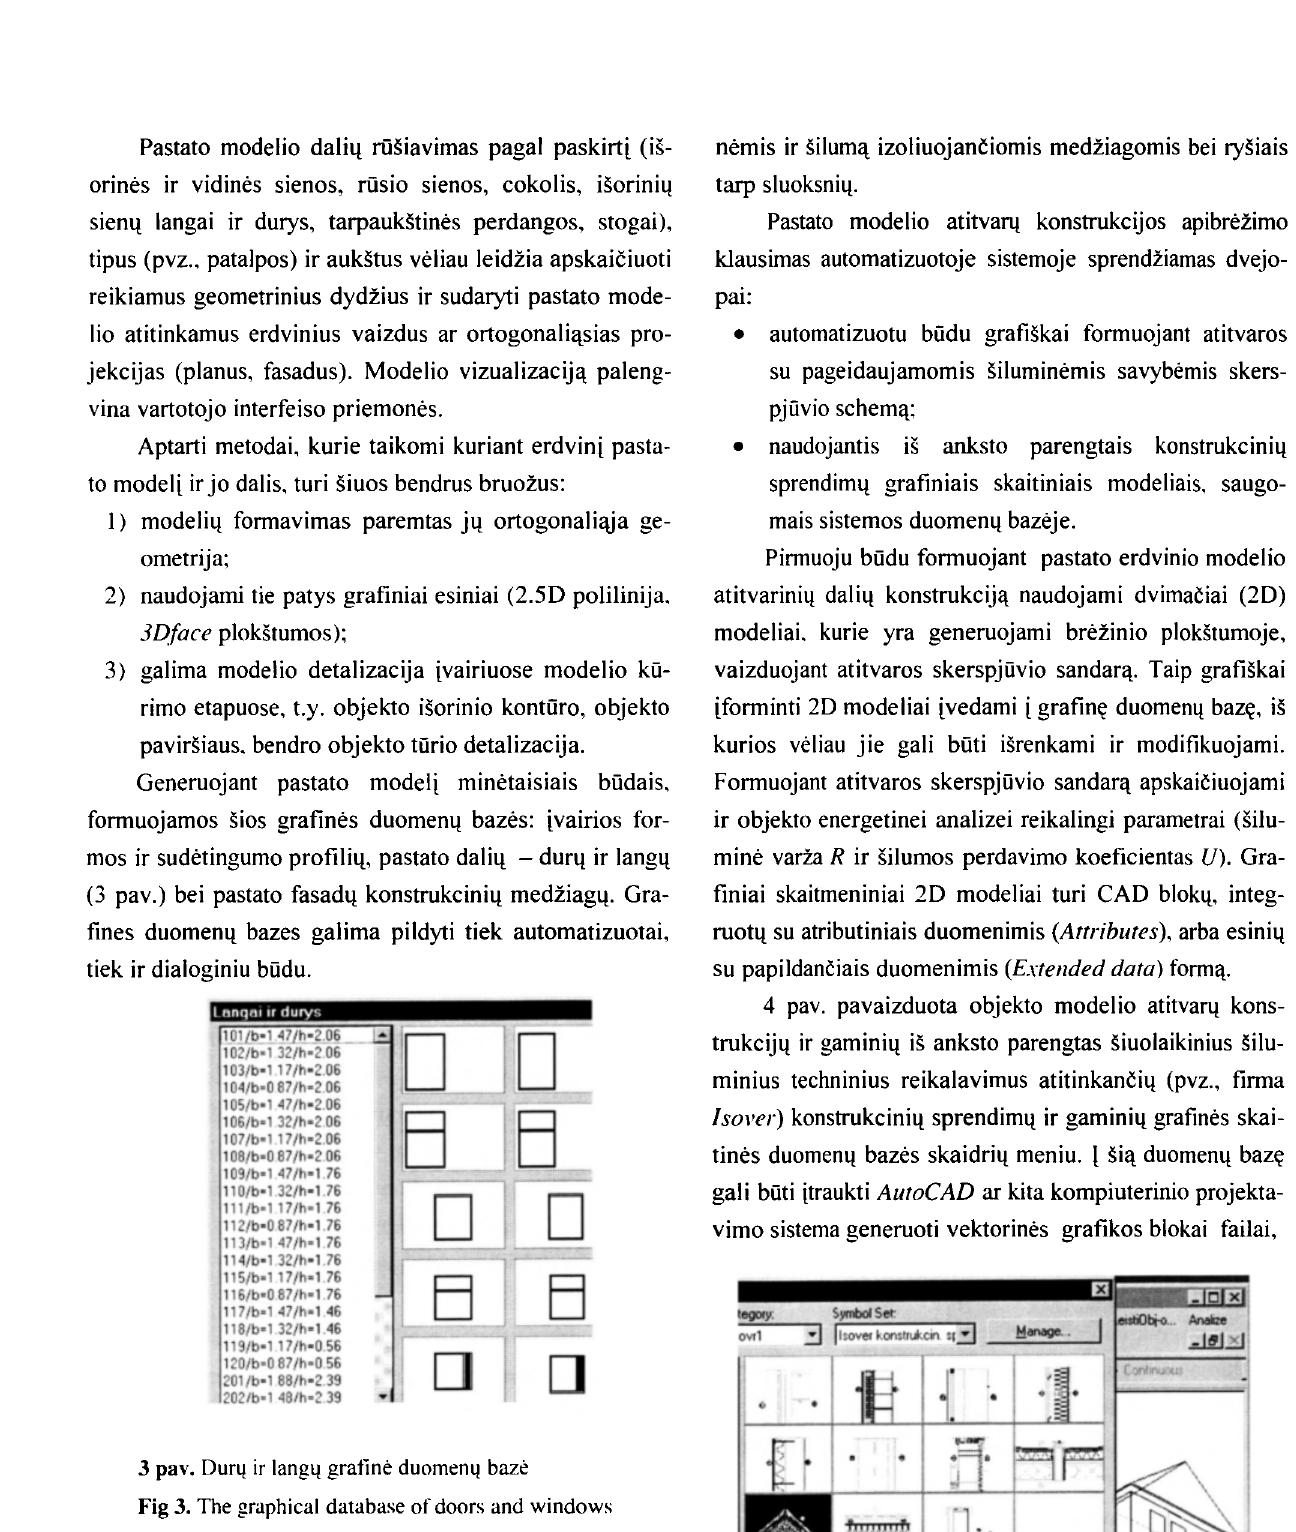
Fig 3. The graphical database of doors and windows